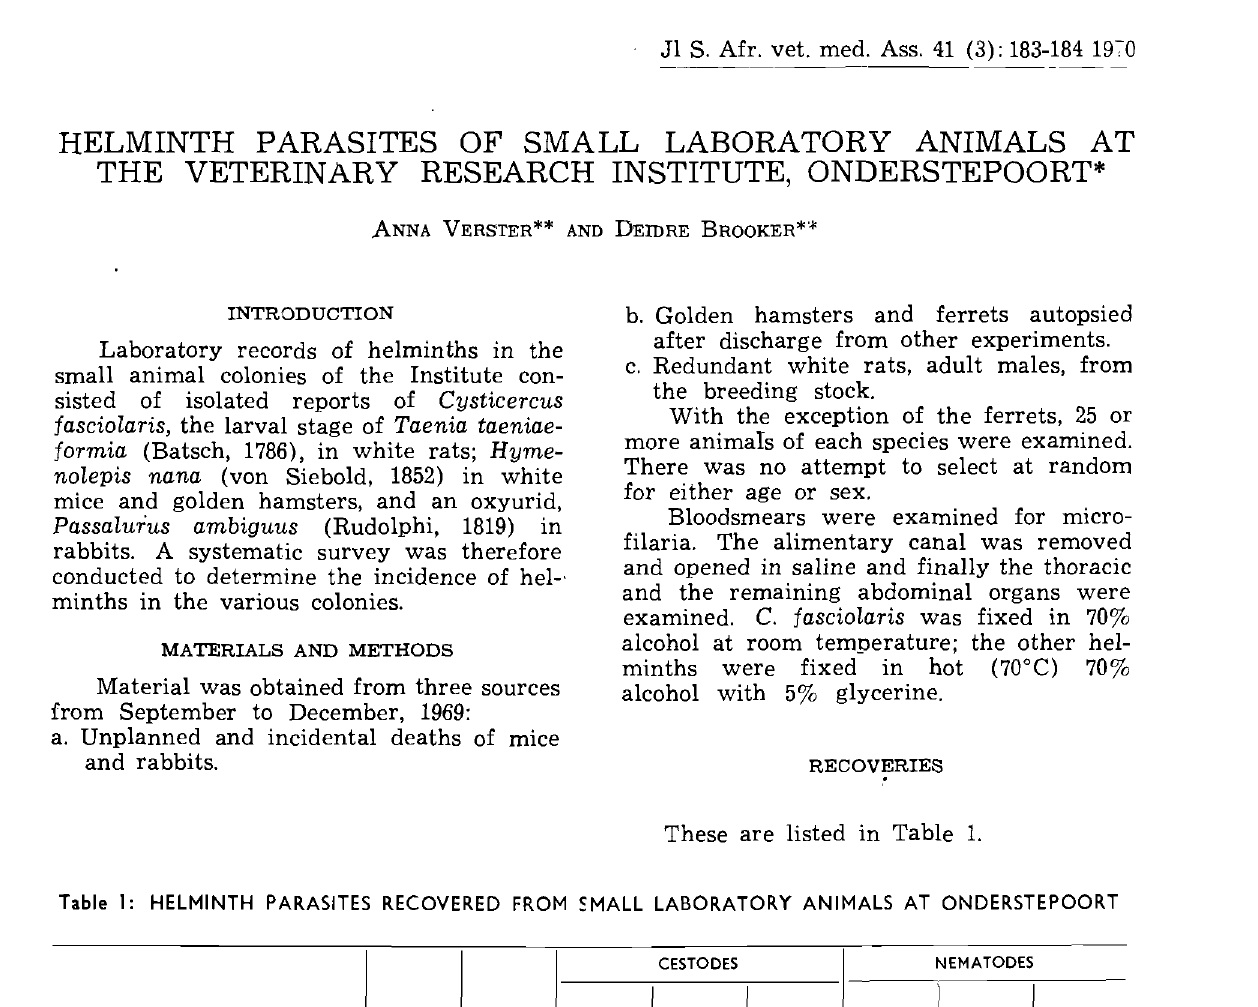
Table 1: HELMINTH PARASITES RECOVERED FROM SMALL LABORATORY ANIMALS AT ONDERSTEPOORT